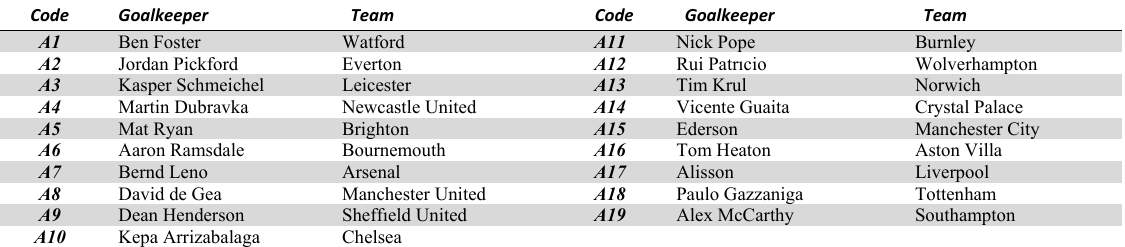
The selection criteria for goalkeeper selection and relative importance scores.